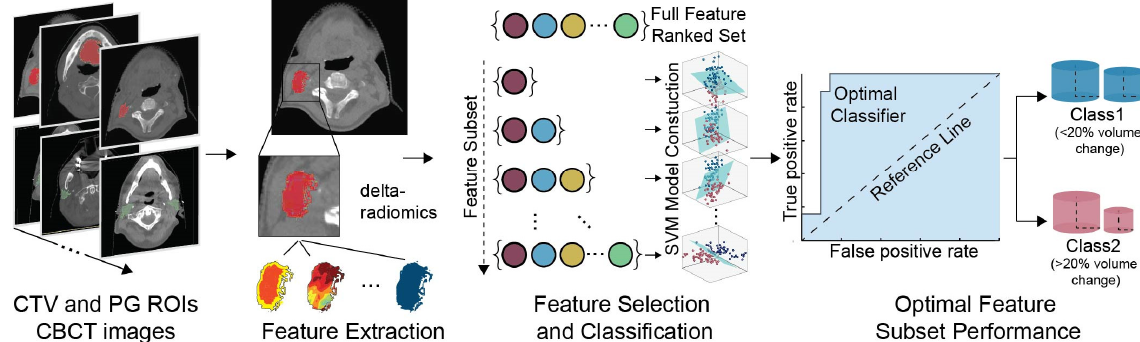
Figure 2. A schematic of the proposed framework workflow. CBCT images from CTV and PG ROIs are employed to calculate delta-radiomics features. The features from both ROIs are then fed into a feature selection and classification scheme to identify the feature subset with the highest discrimination power and assess overall performance.